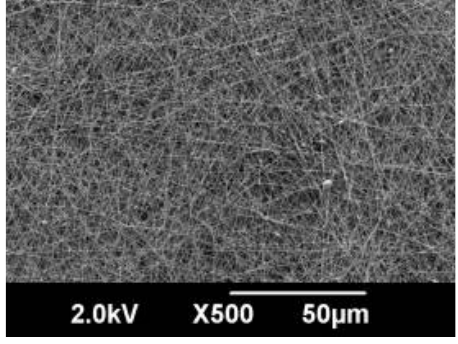
Figure 10. Surface scanning electron micrographs of typical electrospun PAN NFMs coated on glass fibrous nonwoven substrate. Average fiber diameter (D) = 90.4 nm, basis weight = 0.3 g/m 2